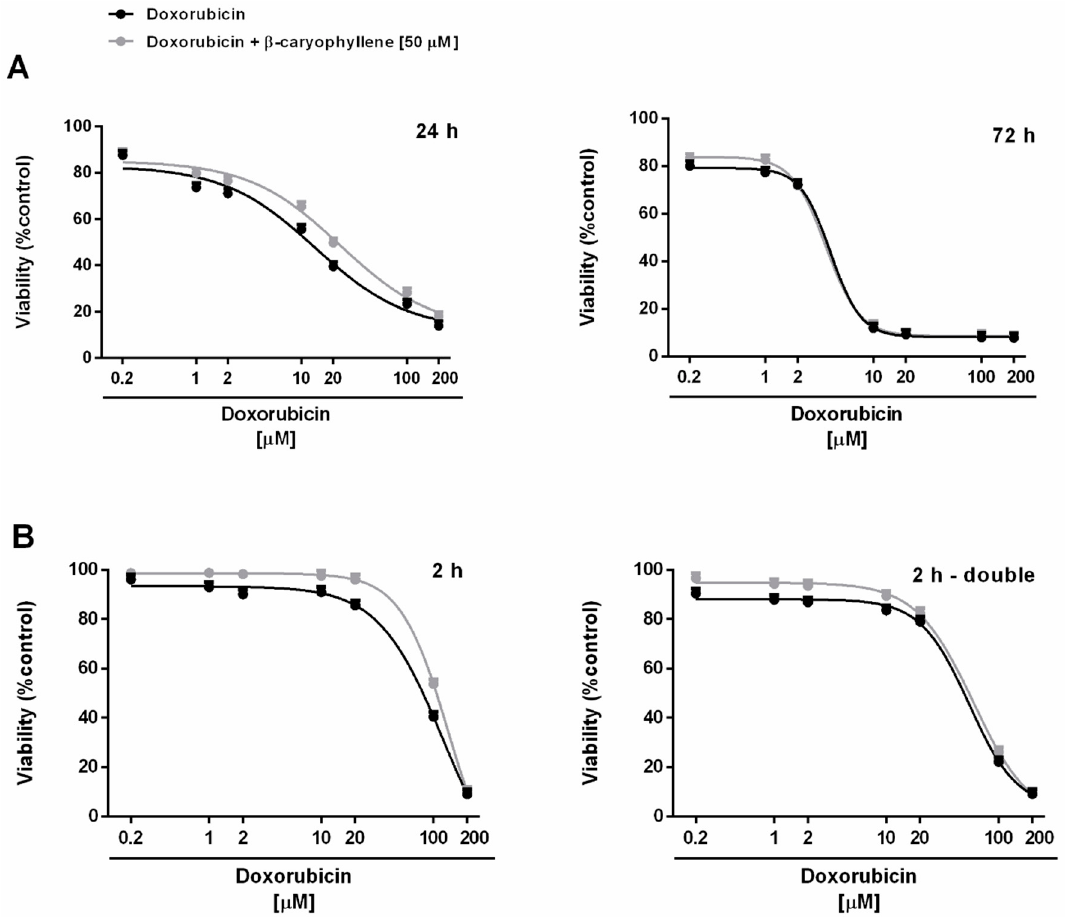
Figure 5. Cytotoxicity of doxorubicin and its combination with β -caryophyllene in H69 noncancerous cholangiocytes. ( A ) Single long-term exposures of 24 h and 72 h. ( B ) Metronomic schedule: the cells were subjected to a single and / or double repeated short exposure of 2 h followed by a recovery time of 72 h. Data are expressed as mean ± SE (standard error) of at least two experiments in which each treatment was tested at least in triplicate ( n =